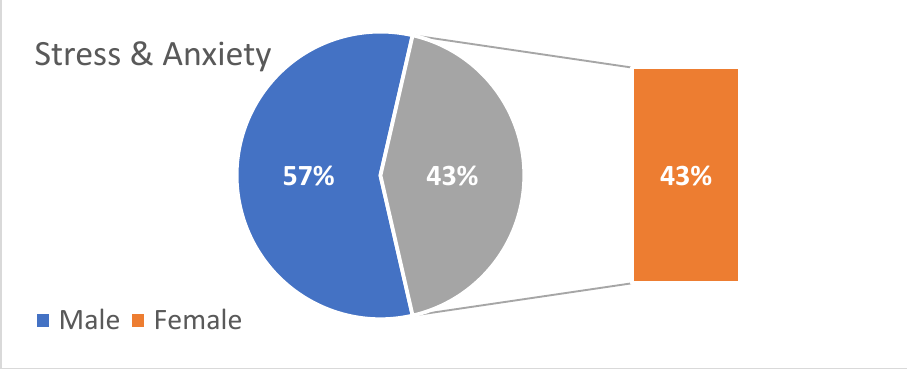
Figure 6. Stress and anxiety analysis of proposed model.